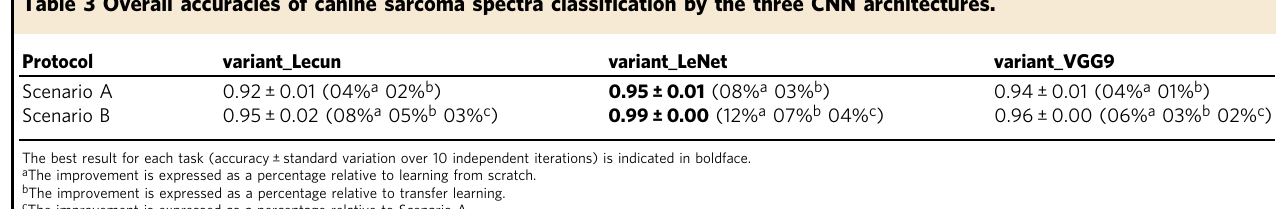
Table 3 Overall accuracies of canine sarcoma spectra classi fi cation by the three CNN